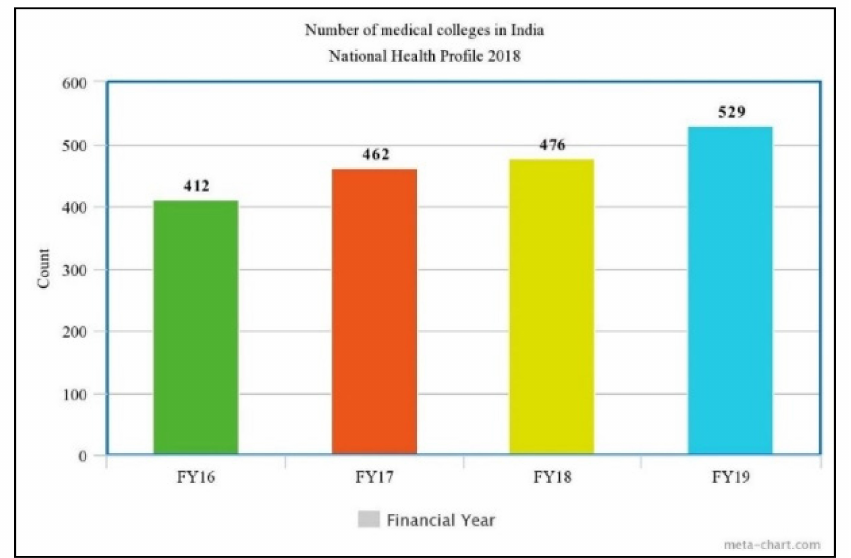
Figure 8. Number of medical colleges in India